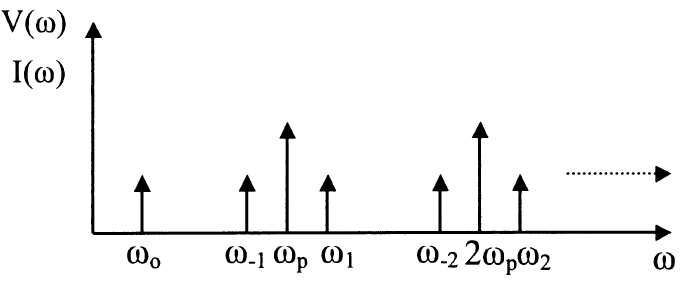
FIGURE 3 Small-signal mixing frequencies o n